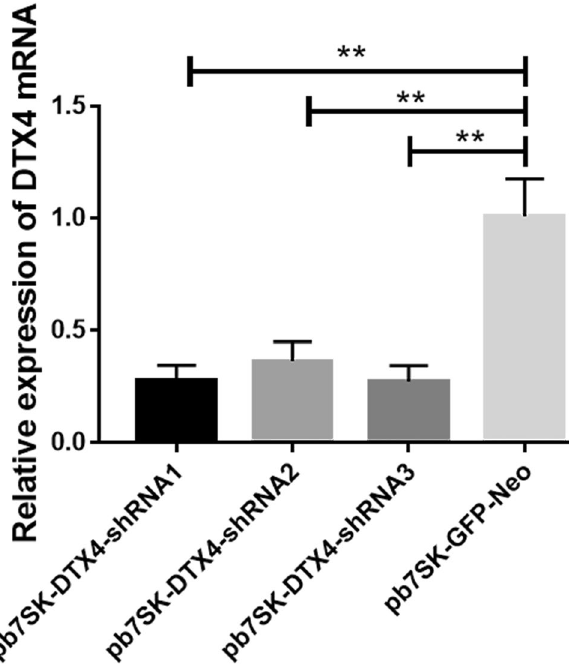
Figure 8. Relative expression levels of DTX4 mRNA in bMECs transfected with the following vectors: pb7SK- DTX4 -shRNA1, pb7SK- DTX4 -shRNA2, pb7SK- DTX4 -shRNA3, or pb7SK-GFP-Neo (** P < 0.01).